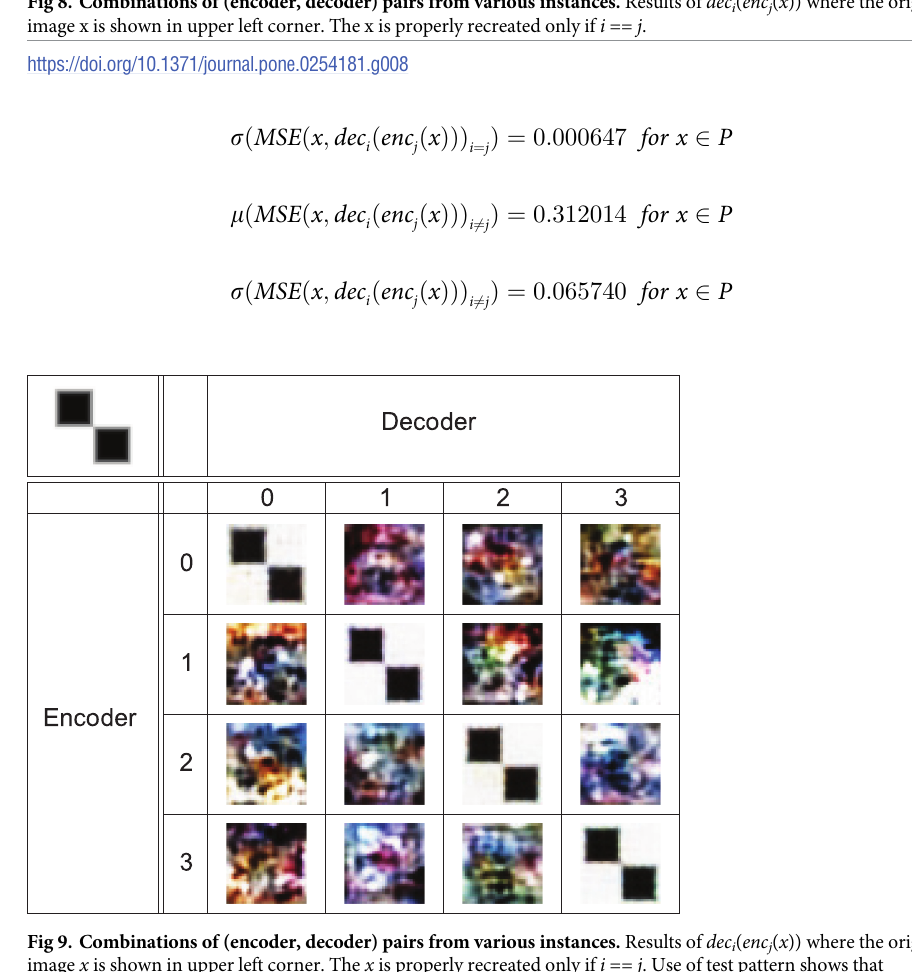
( enc ( x )) where the original i j